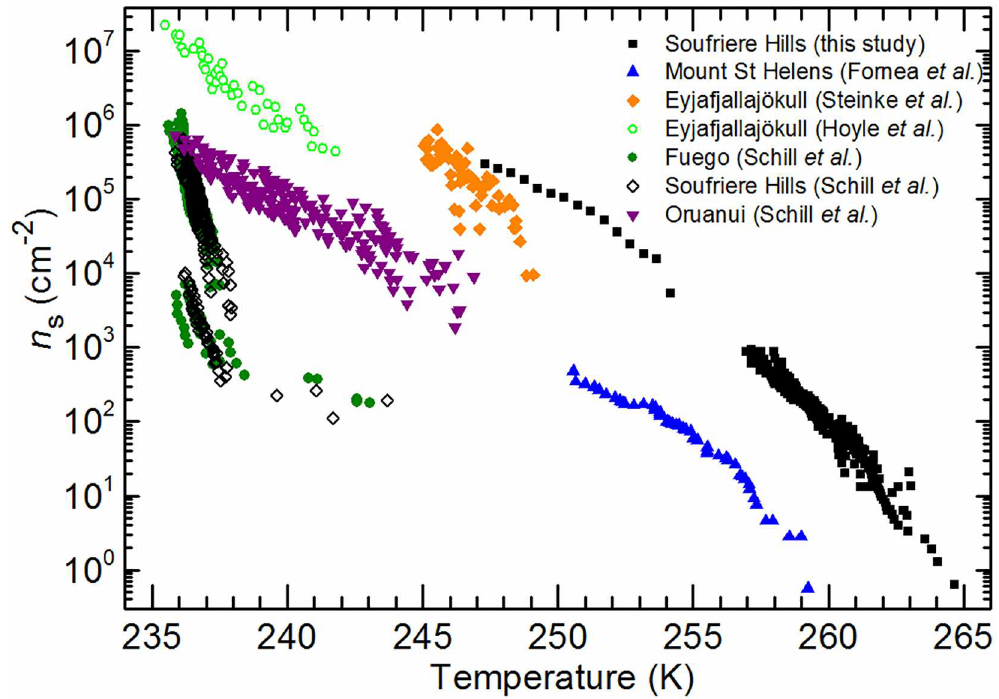
Fig 3. Values of n s in units of cm -2 as a function of temperature, for ice nucleation by volcanic ashes in the immersion/condensation modes from this study and the literature